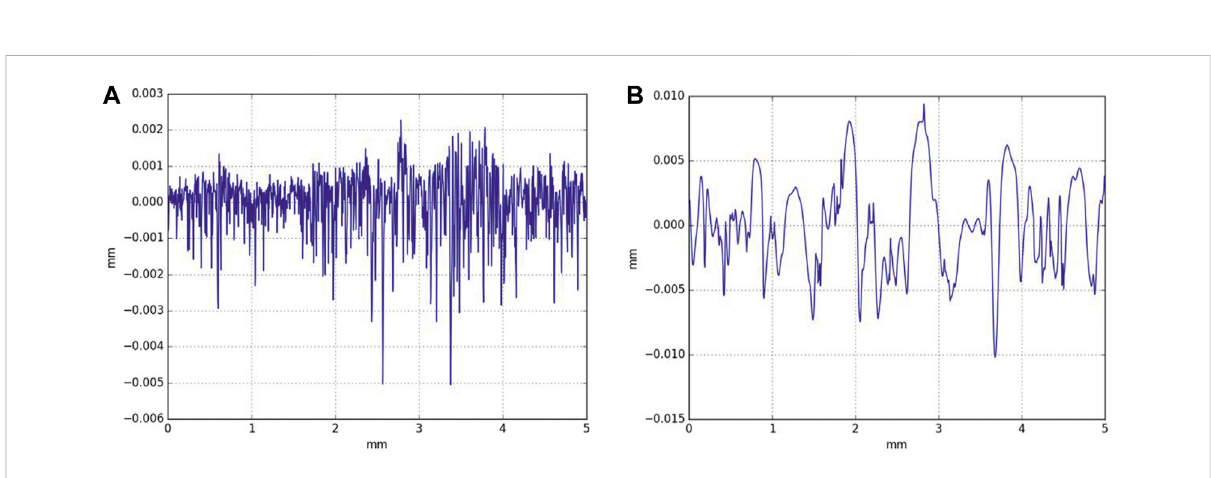
FIGURE 2 Pro fi lometric study of both prepregs (A) Prepreg A (B) Prepreg